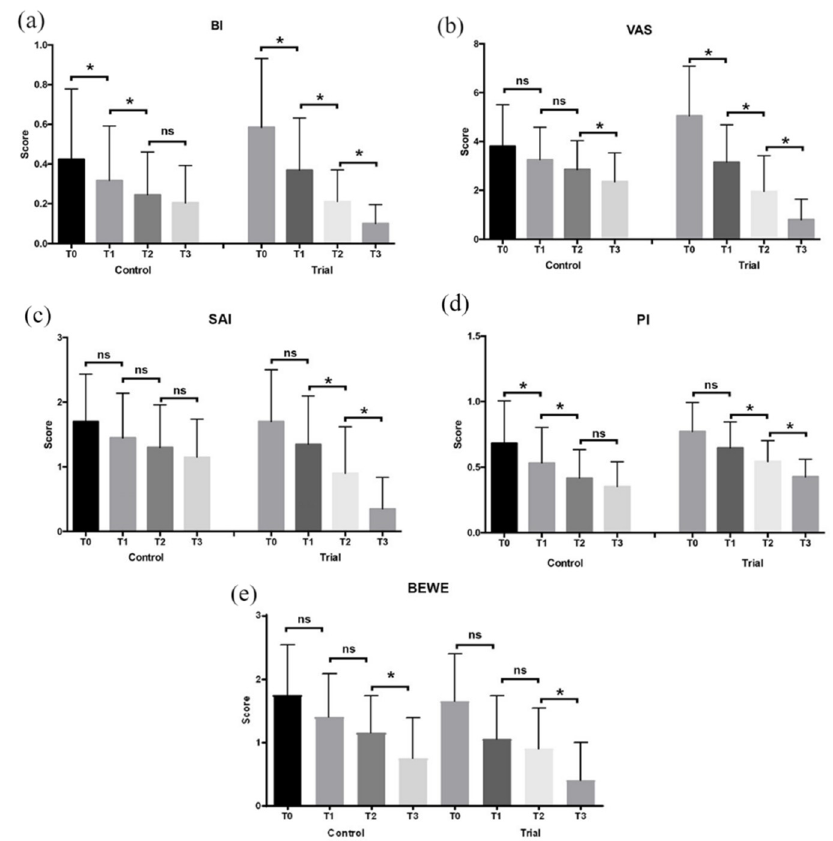
Figure 2. Diagrams of the clinical indexes (mean and SD) assessed at T0, T1, T2, and T3: ( a ) Bleeding Index; ( b ) Visual Analogue Scale; ( c ) Schiff Air Index; ( d ) Plaque Index; ( e ) Basic Erosive Wear Examination. Legend: ns: not significant; *: p < 0.05.